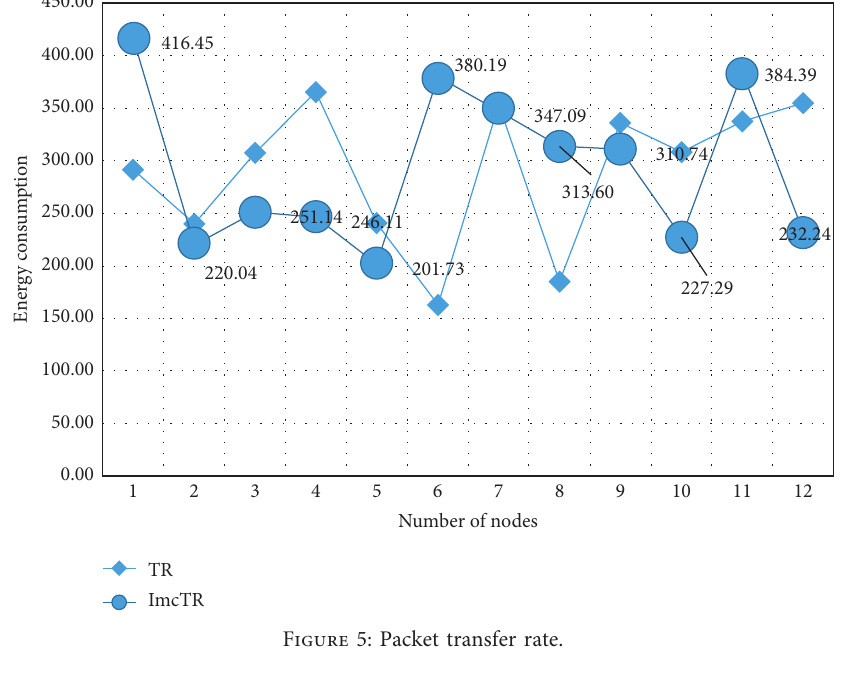
Figure 5: Packet transfer